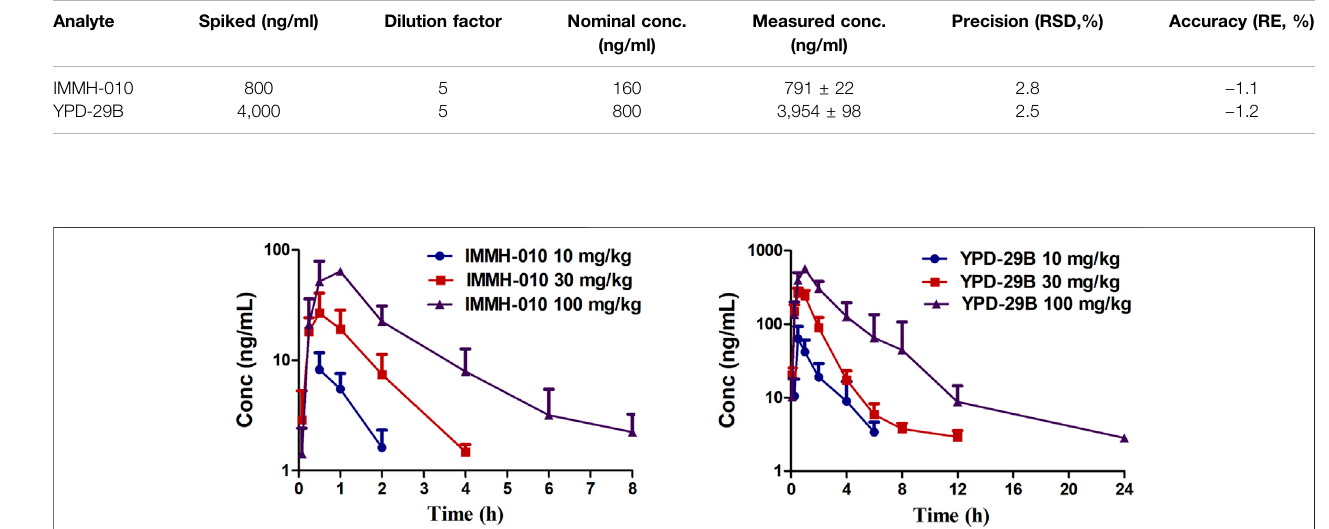
FIGURE3| Concentration-timepro fi lesofIMMH-010anditsactivemetabolitesYPD-29Binratsafterasinglei.g.administrationofIMMH-010maleateatdosesof 10, 30, 100 mg/kg ( n (cid:1) 5).